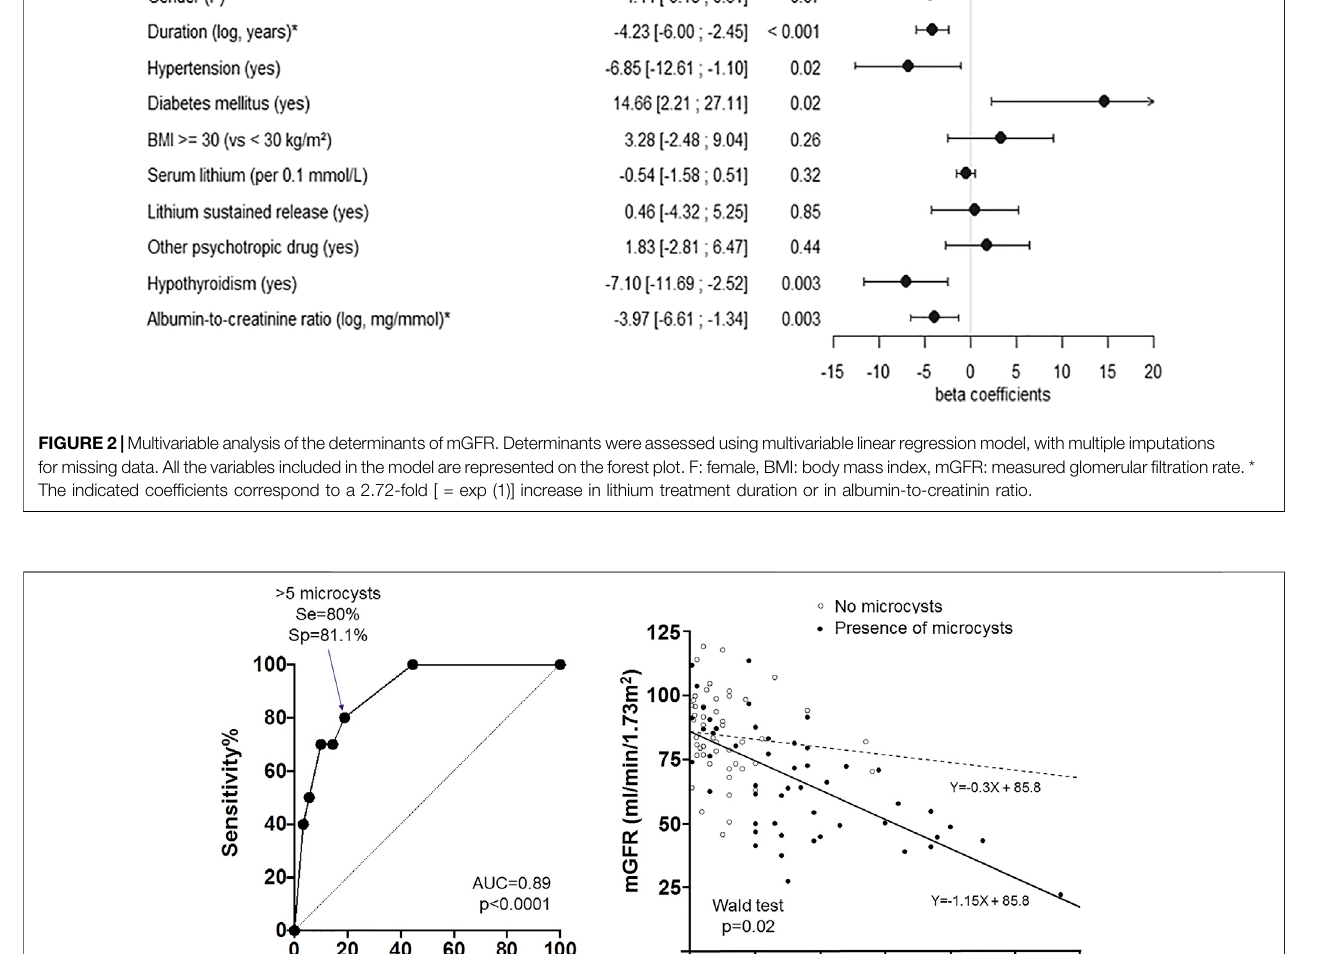
Frontiers in Pharmacology |